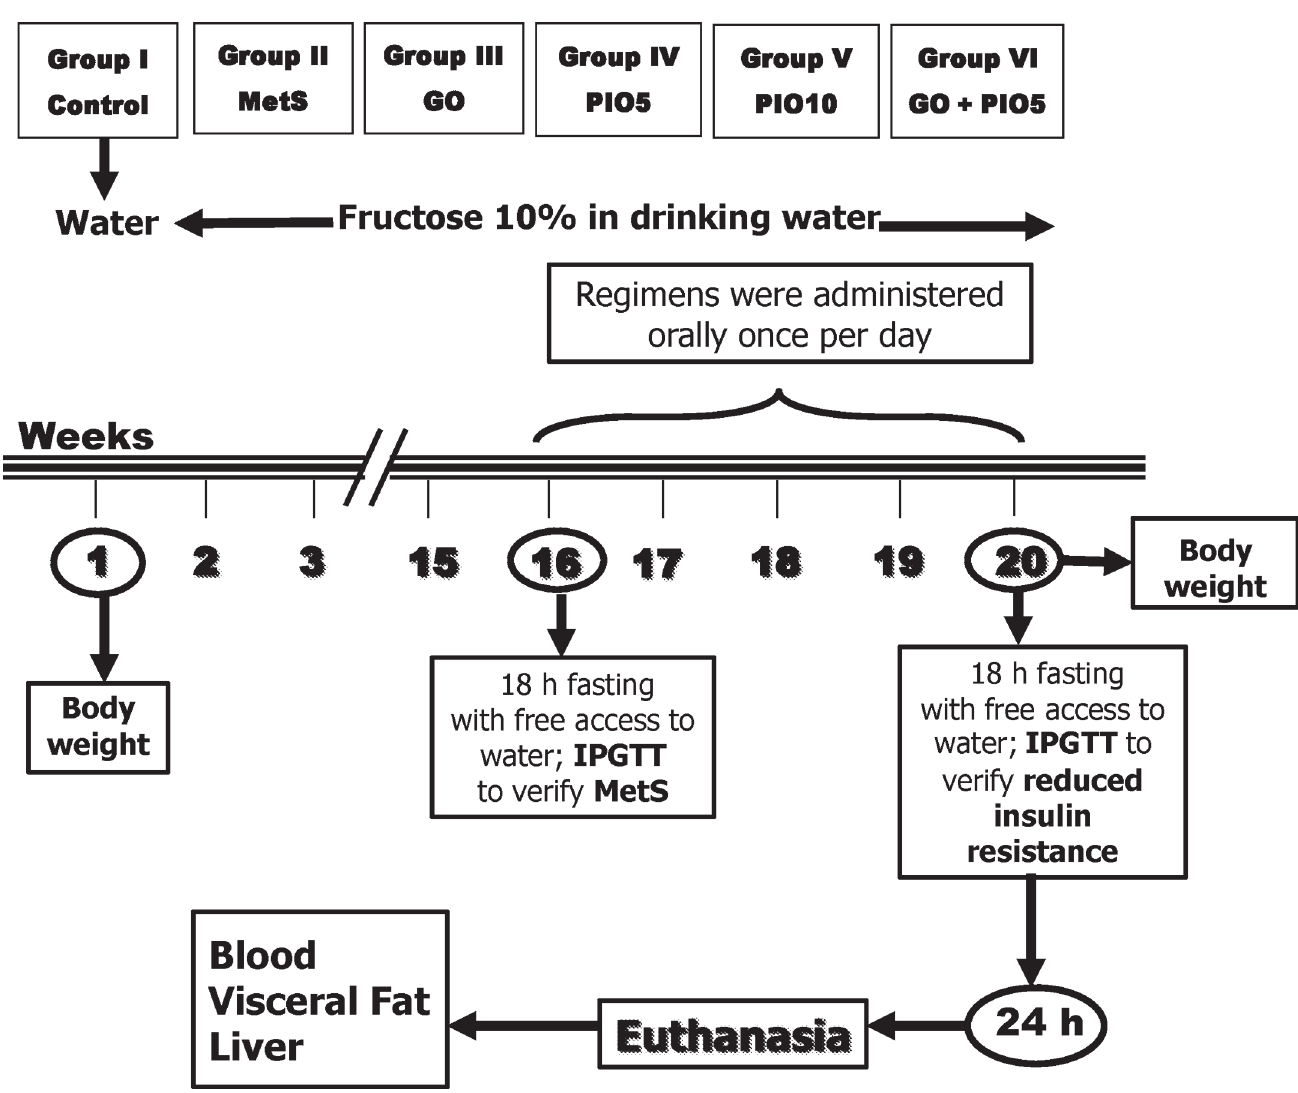
Fig 1. Adult male Wistar rats (45 days; 170 ± 20 g) were randomly divided into 2 experimental subsets, namely, control group (free access to water for 16 weeks then vehicle for 4 weeks) or metabolic syndrome (MetS; 10% fructose solution in drinking water for 16 weeks) subset. After 16 weeks, all animals were exposed to the intraperitoneal glucose tolerance test (IPGTT) after an overnight fast; and MetS was verified in the fructose fed rats. In the MetS experimental subset, rats were subdivided into MetS (1% Tween 80; 4 weeks; p.o), geraniol (GO; 250 mg/kg/day; 4 weeks; p.o); pioglitazone (PIO; 5 and 10 mg/kg/day; 4 weeks; p.o), and GO/PIO5 groups. These animals were further supplied with 10% fructose solution in drinking water for 4 weeks. Insulin resistance was tested using IPGTT 24 h after last treatments or vehicle administration and after an overnight fast in all groups. Body weight was recorded at baseline and after 20 weeks of the beginning of the experiments. Blood was collected and then rats were euthanized to dissect the liver and visceral fat for different